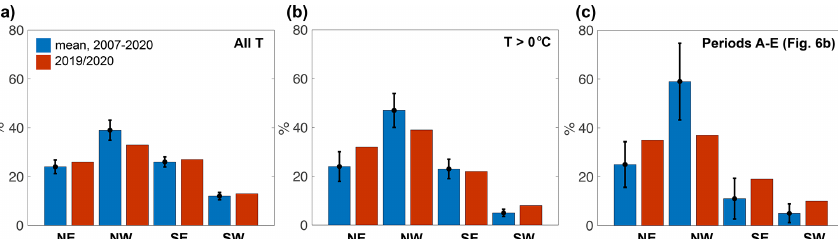
Figure 8. Percentage (%) of wind each season (1 November to 31 March) at Fossil Bluff AWS that is northeasterly (NE), northwesterly (NW), southeasterly (SE), and southwesterly (SW), with the interannual (2007/2008 to 2019/2020) mean shown in blue and the 2019/2020 values shown in red. (a) Wind direction proportions using all recorded air temperatures. (b) Wind direction proportions only when recorded temperatures are ≥ 0 ◦ C. (c) Wind direction proportions only during the five longest periods of T ≥ 0 ◦ C (A to E, Fig. 7b) for all melt seasons (blue) and for 2019/2020